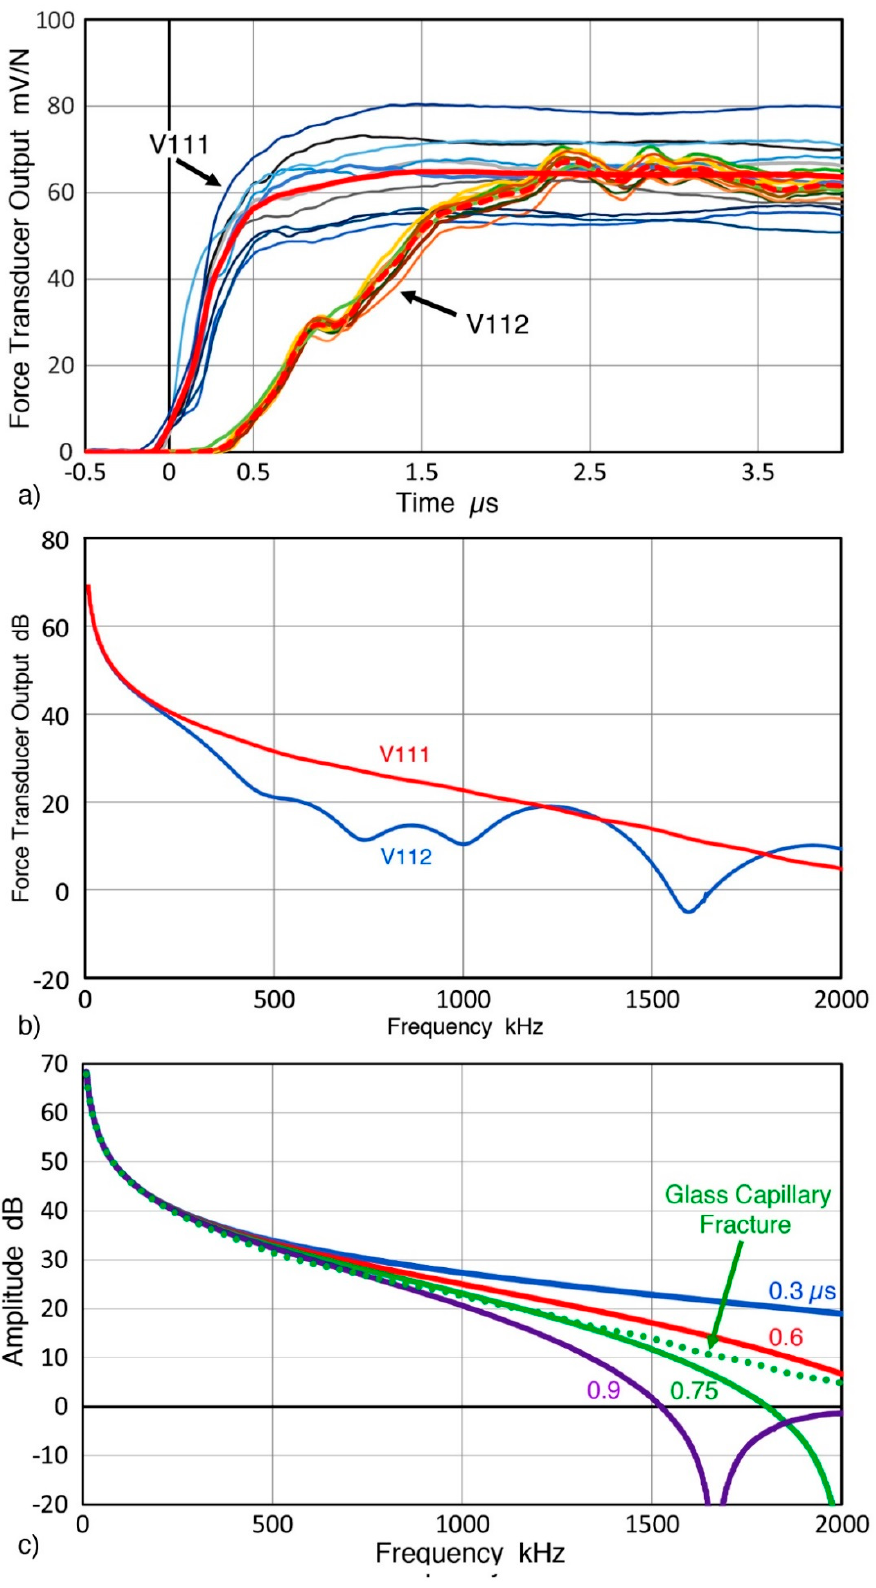
Figure 5. ( a ) The output voltages from force transducers (V111 and V112) vs. time during the fracture of 10 GC tubes. ( b ) Fast Fourier-transform (FFT) spectra of the force–time curves in Figure 5a. ( c ) FFT of V111 in Figure 5b is given in green dot curve and FFT of cosine bell functions of four rise times in solid curves. Rise time values are 0.3 µ s (blue), 0.6 µ s (red), 0.75 µ s (green), and 0.9 µ s (purple), respectively.